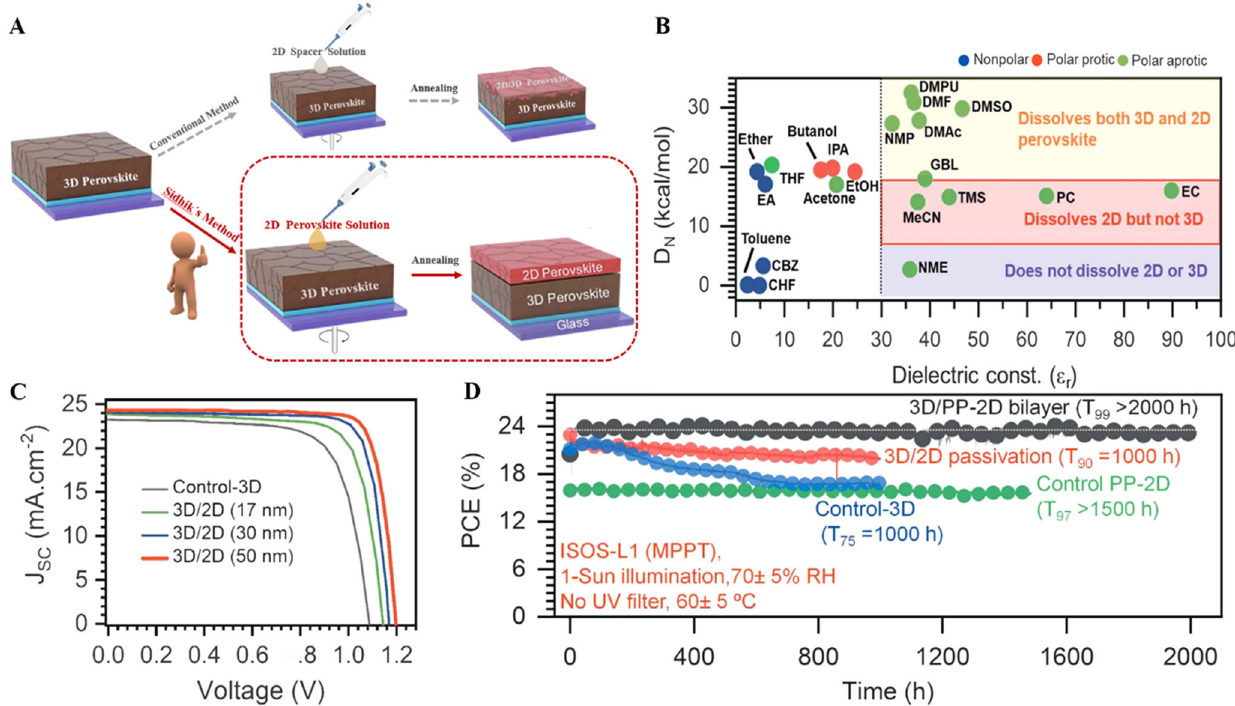
Fig. 1 Preparation of 2D/3D perovskite bilayer heterojunctions and performance comparison of different methods and solvents. A Schematic illustration of preparing 3D/2D perovskite bilayer heterojunctions with different methods. B Comparison of different solvents based on dielectric constant ( Ɛ r ) and Gutmann number (D N ). C Current – voltage curves of the champion 3D/2D perovskite bilayer heterojunction PSCs. D Stability assessment of the 3D/2D-based modules with different perovskite fi lms at maximum power point tracking in an ambient atmosphere. A Adapted and ( B – D ) reproduced from Science 377 , 1425 – 1430 (2022). Reprinted with permission from